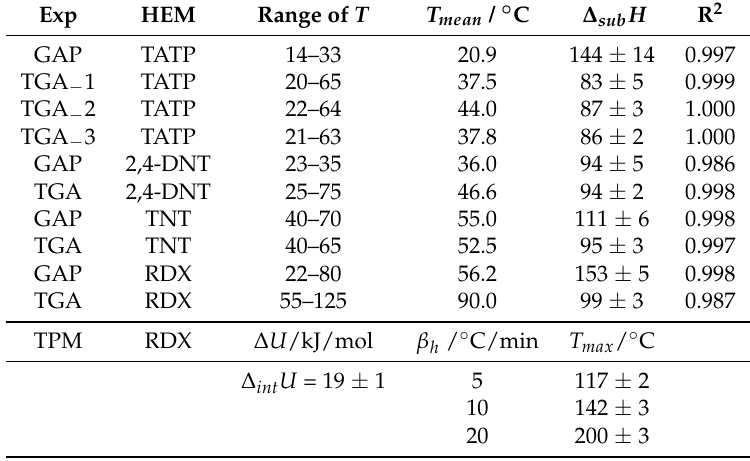
Table 1. Enthalpy of sublimation for HEM and desorption energy for RDX on SS.